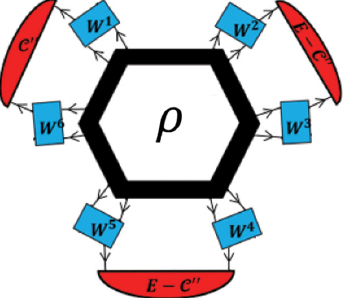
FIG. 18. Contraction of 2 → 1 connectors used to detect entanglement of a many-body mixed state ρ . Here, C 0 ¼ SWAP is the witness for certifying entanglement in the singlet state j Ψ − i .